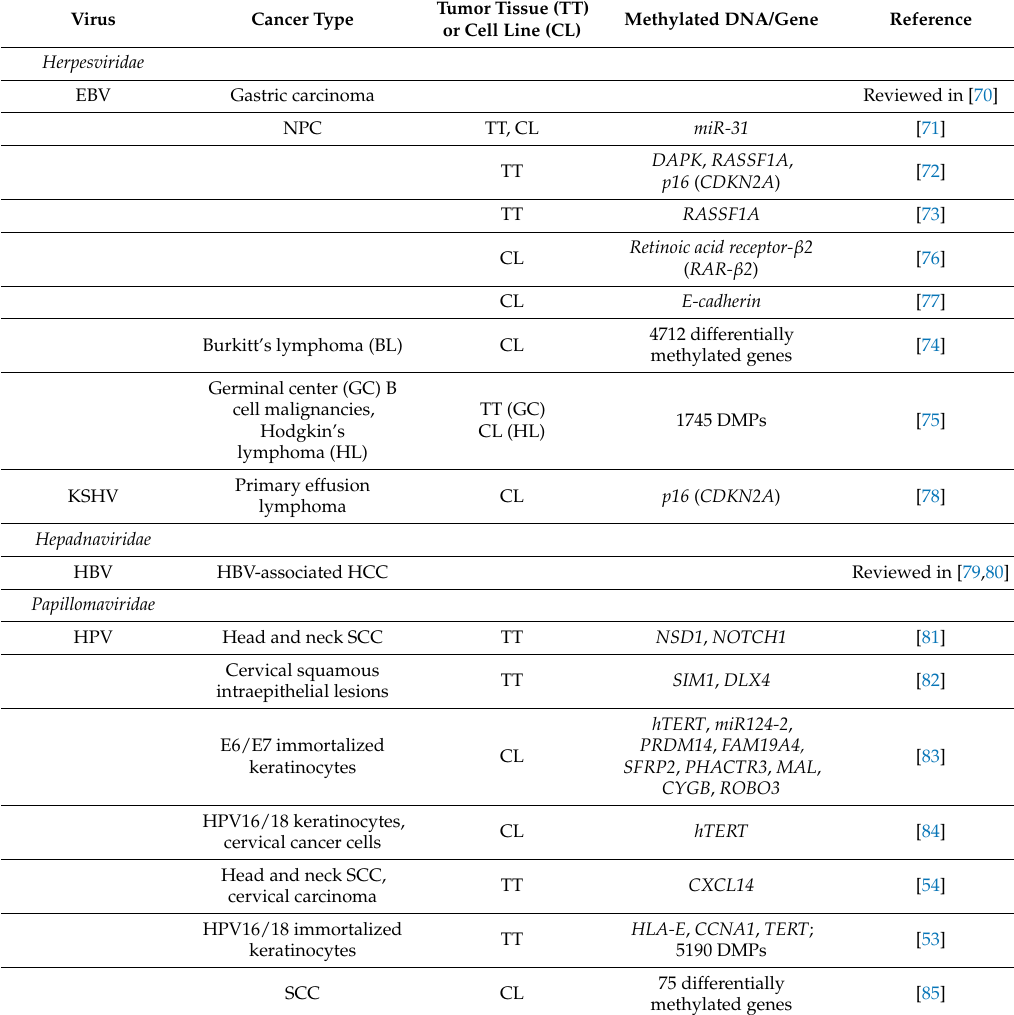
Table 1. DNA methylation associated with DNA tumor virus-induced